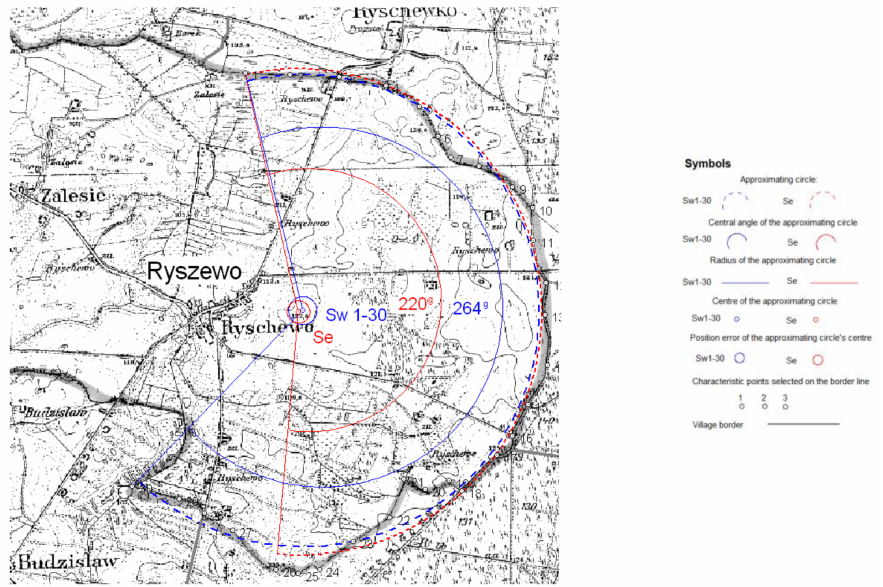
Figure 10. Ryszewo. Course, position and error of the approximating circle: Sw 1—30— approximation of points 1—30, Se—approximation of points 3—28, without points 8, 9, 23. Scale 1:50,000.